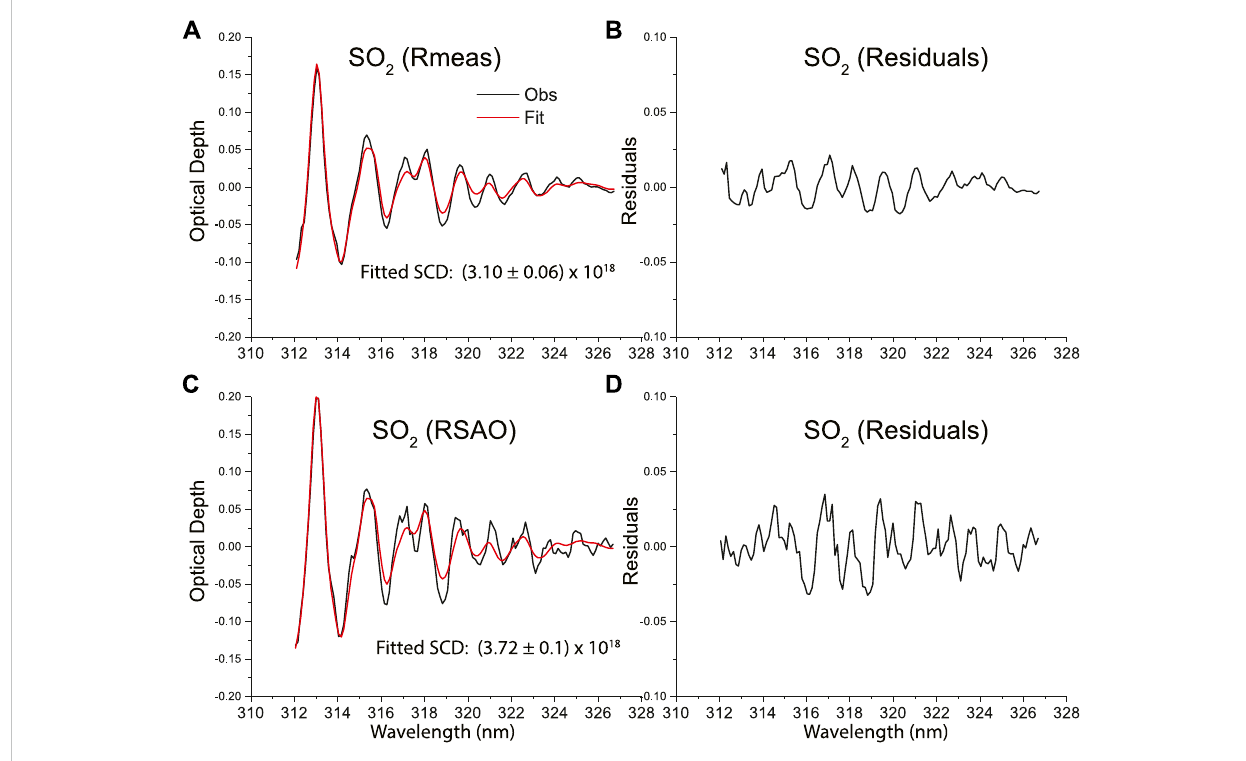
FIGURE 2 Example of fi t of SO 2 analyzed in the 312.0 – 326.8 nm spectral window from the S2000 DOAS measurements at ALTZ station performed on 20February2019using (A) themeasuredreference(Rmeas)and (C) theRSAOreference.Thecorrespondingresiduesarepresentedin (B,D) ,respectively. The retrieved slant column density (SCD, in molec/cm 2 ) is shown in the